Question: What does this figure show? Answer in one sentence.
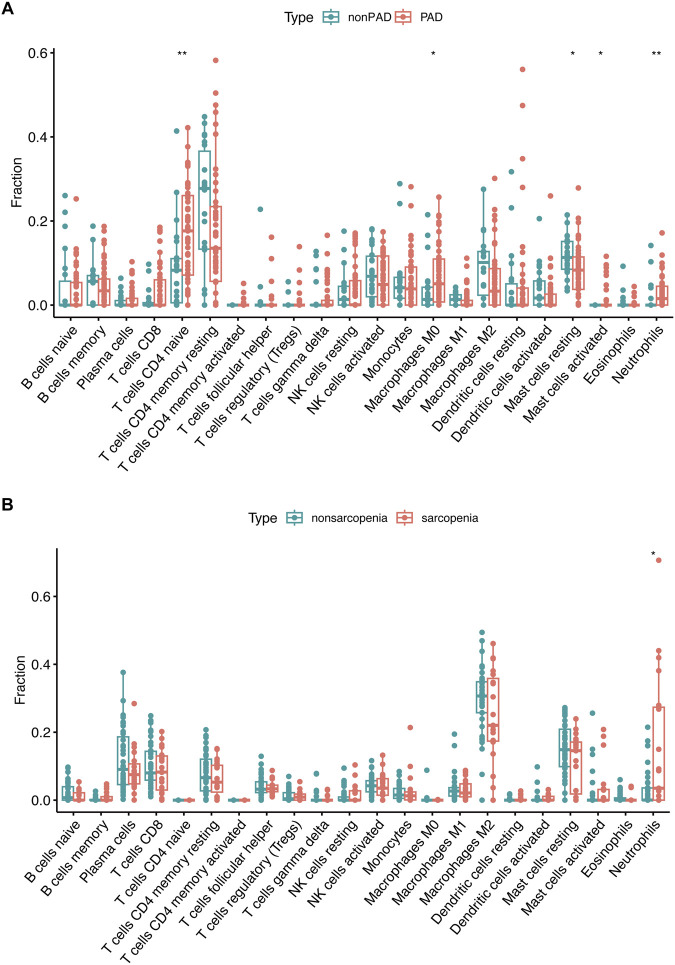
Answer: Immune infiltration analysis of PAD and sarcopenia. (A) Comparison of immune cell infiltration fractions between the nonPAD and Peripheral Artery Disease (PAD) group. (B) Comparison of immune cell infiltration fractions between non-sarcopenia and sarcopenia groups. *P < 0.05, P < 0.01.